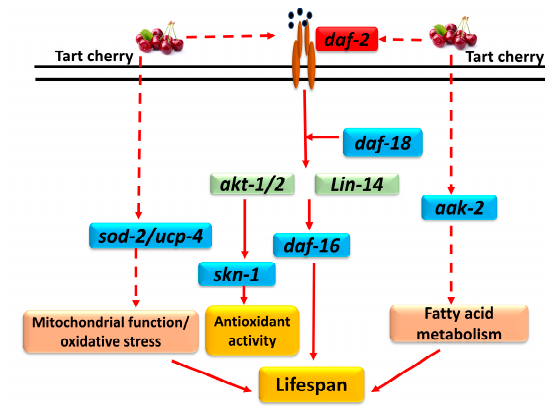
Figure 5. Major molecular targets for TCE in C. elegans . TCE downregulated daf-2 gene and up-regulated daf-16 , daf-18 , skn-1 , sod-2 , ucp-4 , and aak-2 while no changes were observed in akt-1 or lin-14 genes. These molecules may be indirectly involved in regulating mitochondrial function, oxidative stress, ant-oxidant activity, and fatty acid metabolism, and this may subsequently increase lifespan of C. elegans . Downregulated genes are shown in red; up-regulated genes are shown in blue, and those genes that were not changed by TCE are shown in green. Dotted arrows show potential indirect targets of